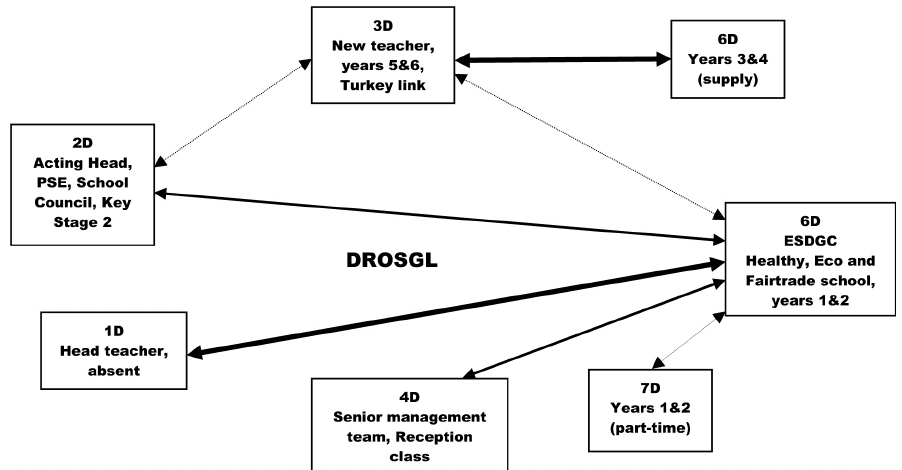
Figure 3d: Drosgl teachers’ networks in